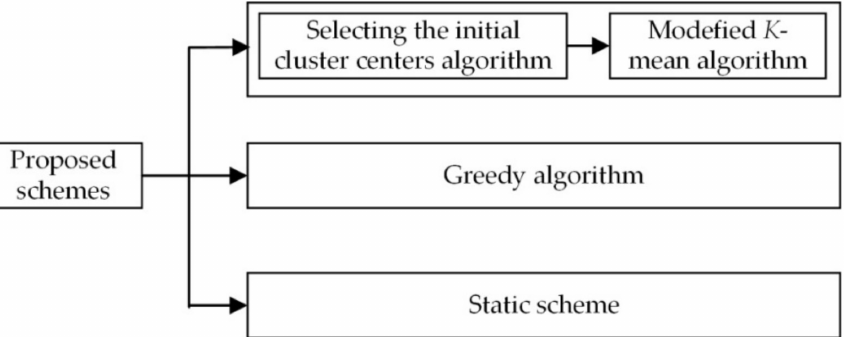
Figure 4. A big picture of all parts of the proposed